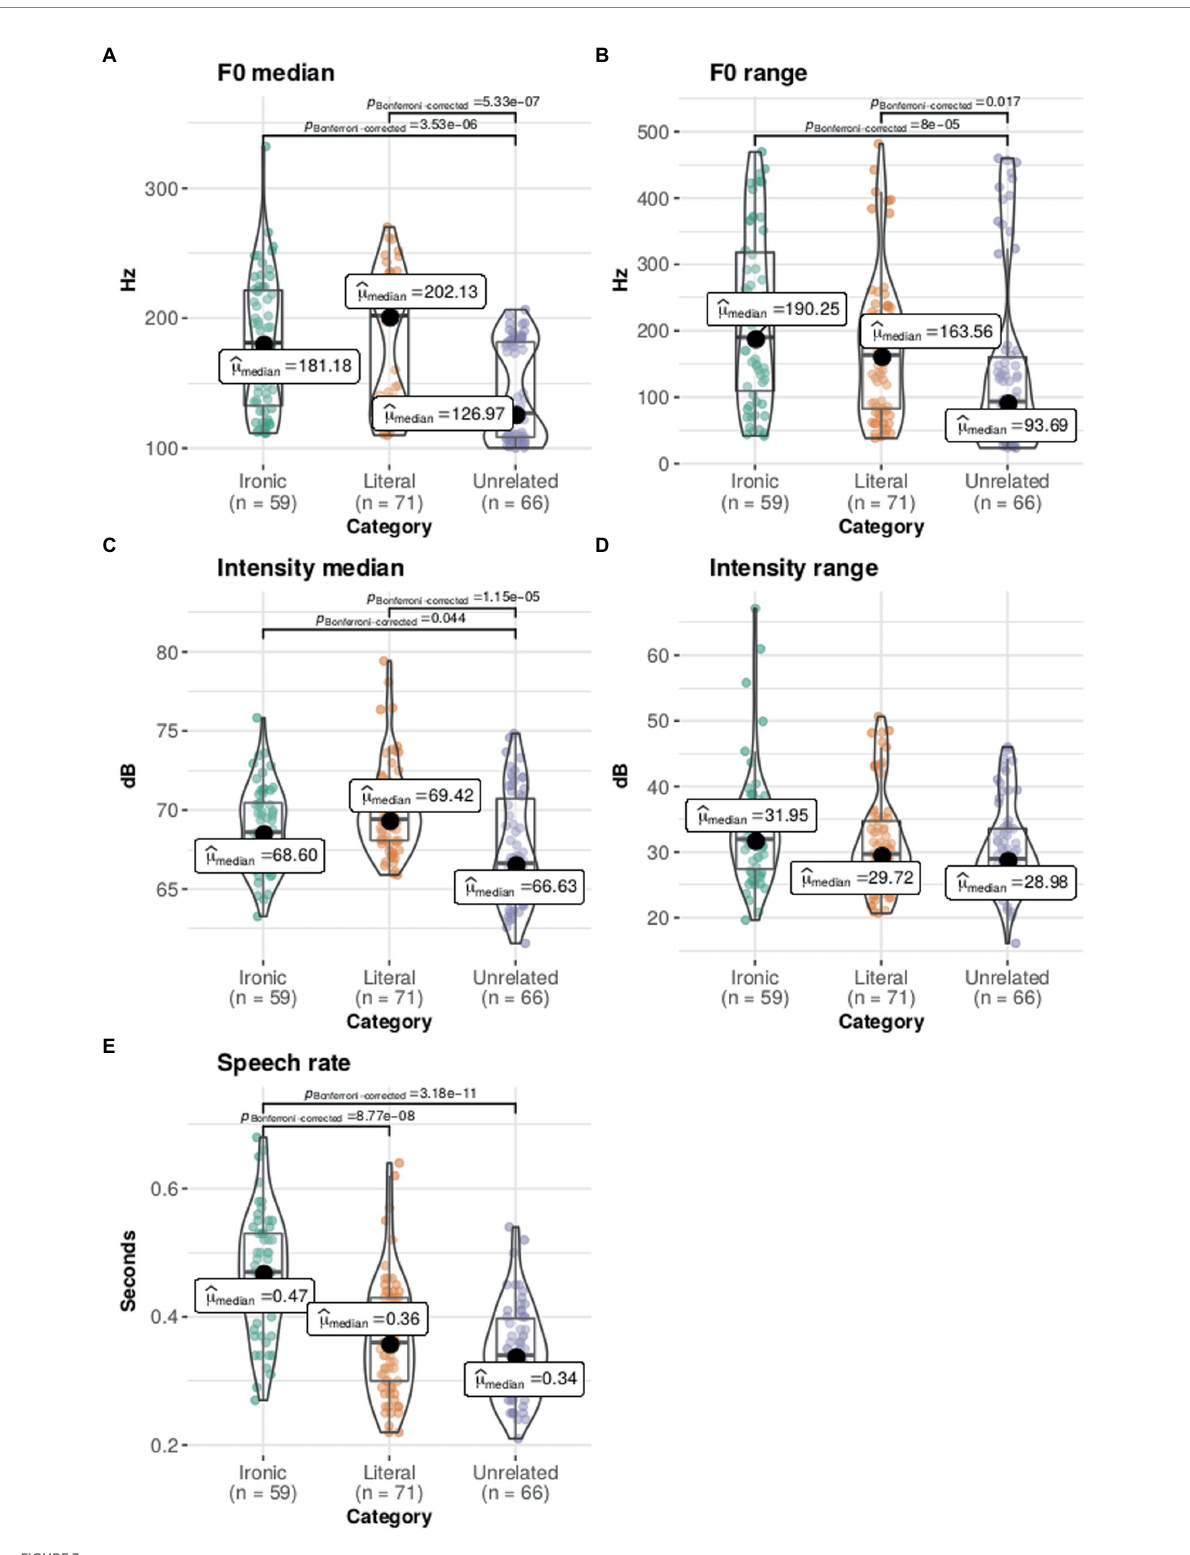
FIGURE 3 Acoustic parameters by statement category. The statement categories can be differentiated by their acoustic pattern. Panels (A, B) show the median and range for the fundamental frequency (F0) in Hz. Panels (C, D) show the median and range for intensity in decibels. Panel (E) shows the speech rate (duration in s/number of words). Plots show the density curves and the box plots show the median (dark circle), mean (thick line), interquartile range (rectangle), and the lower/upper adjacent values (black lines stretched from the rectangle), and scatter plot. Significant differences between categories are